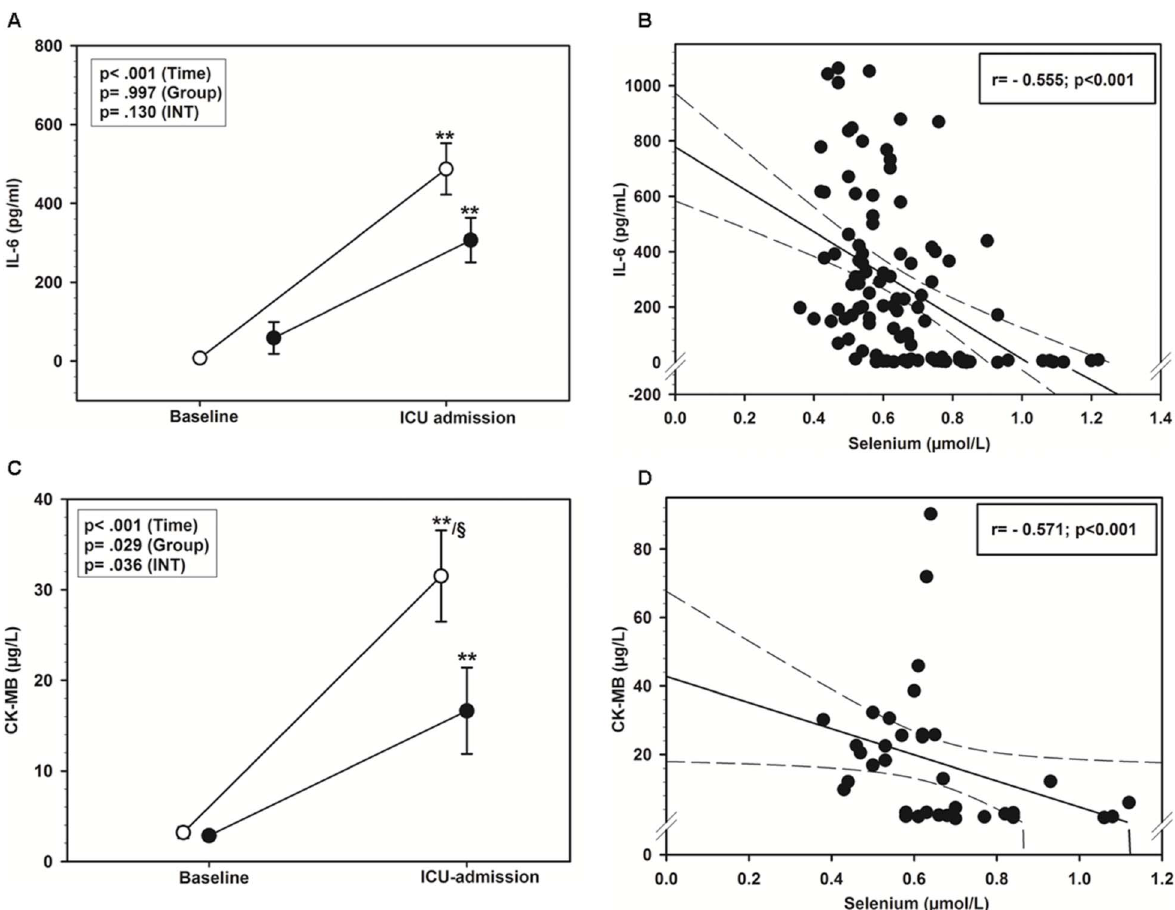
Figure 4. Perioperative inflammatory response and myocardial damage. A ) Comparison of serum IL-6 levels between the on-pump group (open circles) and the OPCAB-group (closed circles) at baseline (preoperative) and at ICU admission (postoperative). Data are presented as mean 6 standard deviation. * p , 0.05, ** p , 0.01 versus baseline, analyzed with 2-way ANOVA. B ) Correlation of whole blood selenium levels and IL-6 levels in serum, between the two groups. Data are depicted as linear regression (black line) with 95% confidence intervals (long dashed line). C ) Comparison of serum CK-MB levels between the on-pump group (open circles) and the OPCAB-group (closed circles) at baseline (preoperative) and at ICU admission (postoperative). Data are presented as mean 6 standard deviation. * p , 0.05, ** p , 0.01 versus baseline, analyzed with 2-way ANOVA. D ) Correlation of whole blood selenium levels and CK-MB in serum between the two groups. Data are depicted as linear regression (black line) with 95% confidence intervals (long dashed line).